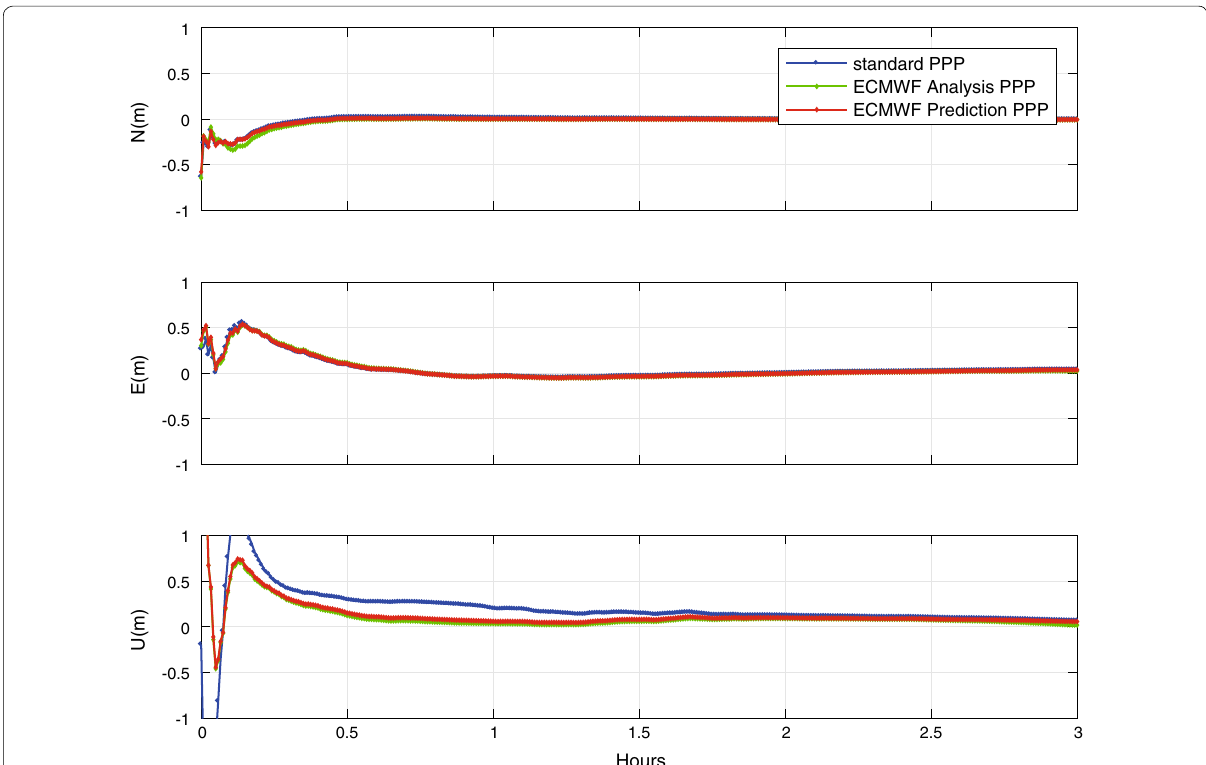
Fig. 2 BeiDou-only PPP solutions at station NNOR on February 15, 2016 [day of year (DOY) 44 of 2016]. Blue denotes the standard PPP solution, green represents the ECMWF-augmented PPP solution with analysis data, and red stands for the ECMWF-augmented PPP solution with prediction